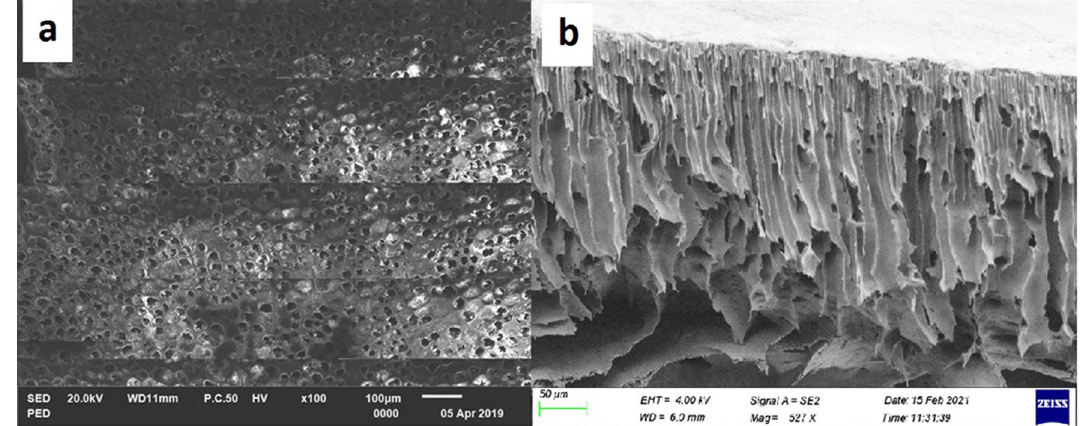
Figure 3. SEM Morphology micro images of pure PES membrane ( a ) surface micro image ( b ) cross sectional